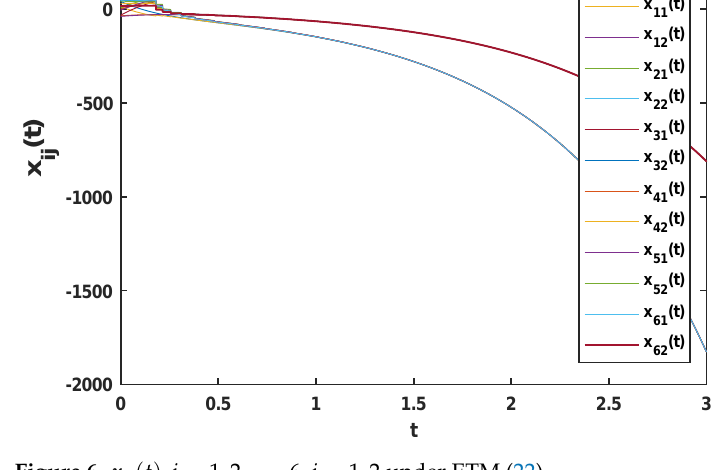
Figure 6. x ij ( t ) , i = 1,2, . . . ,6, j = 1,2 under ETM (22).